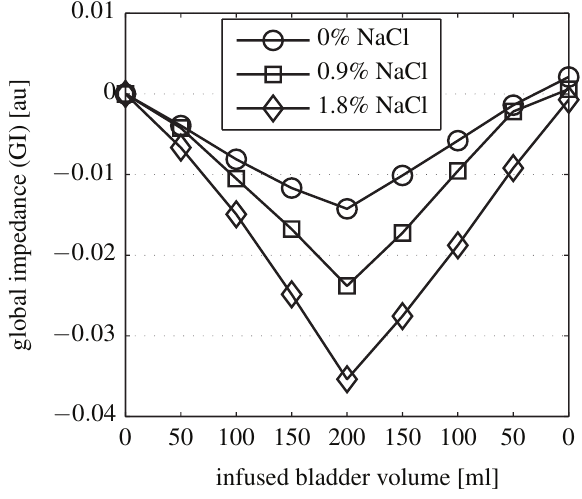
Fig.3: Influence of urine conductivity on EIT global impedance: the slope of the impedance-volume-mapping is influenced by urine conductivity.